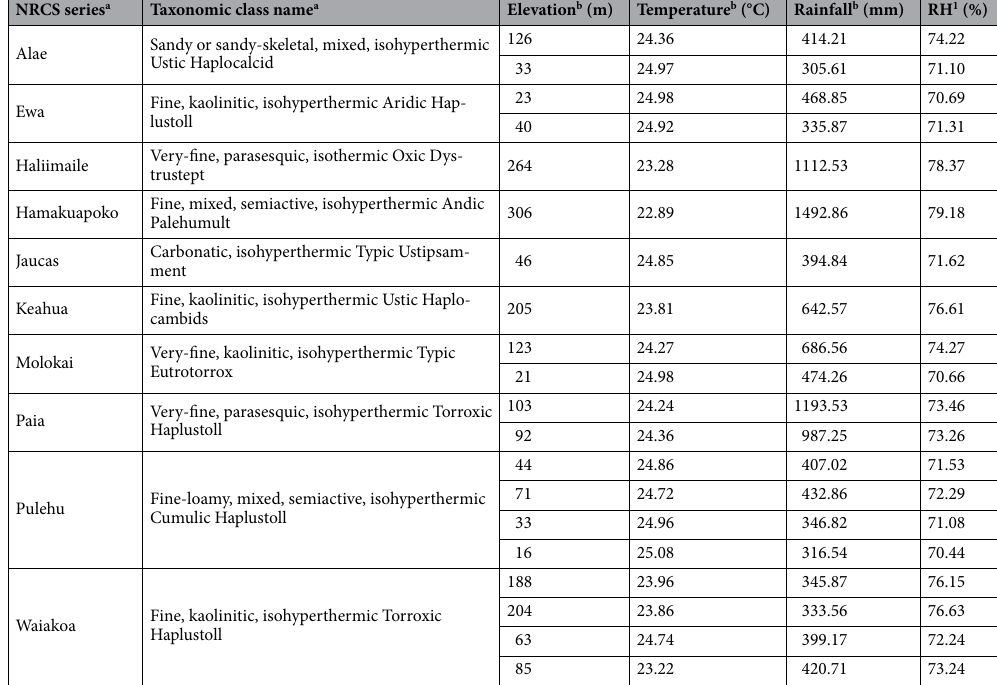
Table 1. NRCS soil classification and environmental conditions at 20 field